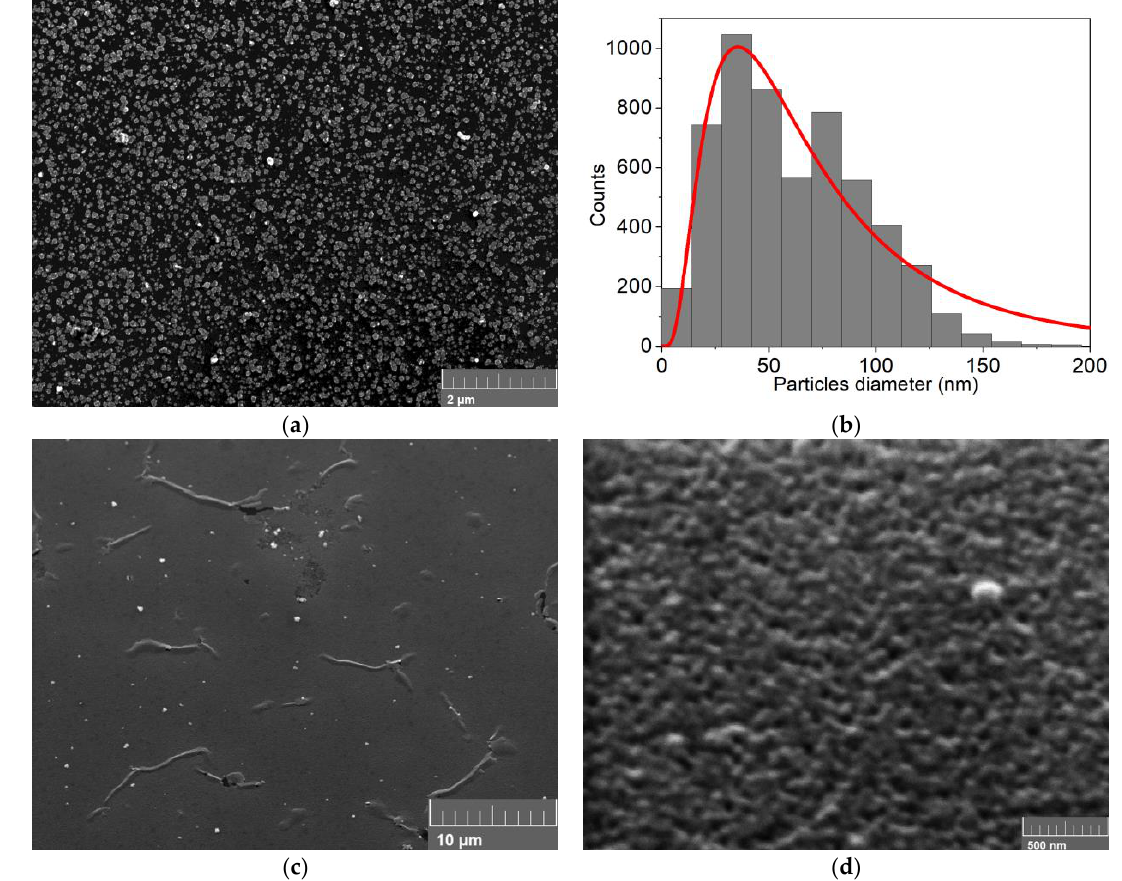
Figure 7. ( a ) SEM analysis of 10 nmol of CdSe co-deposited on n-Si (sample D); ( b ) particles distribution obtained from the SEM image a; ( c ) SEM analysis of 30 nmol of CdSe co-deposited on n-Si (sample E); ( d ) particles distribution obtained from the SEM image c.